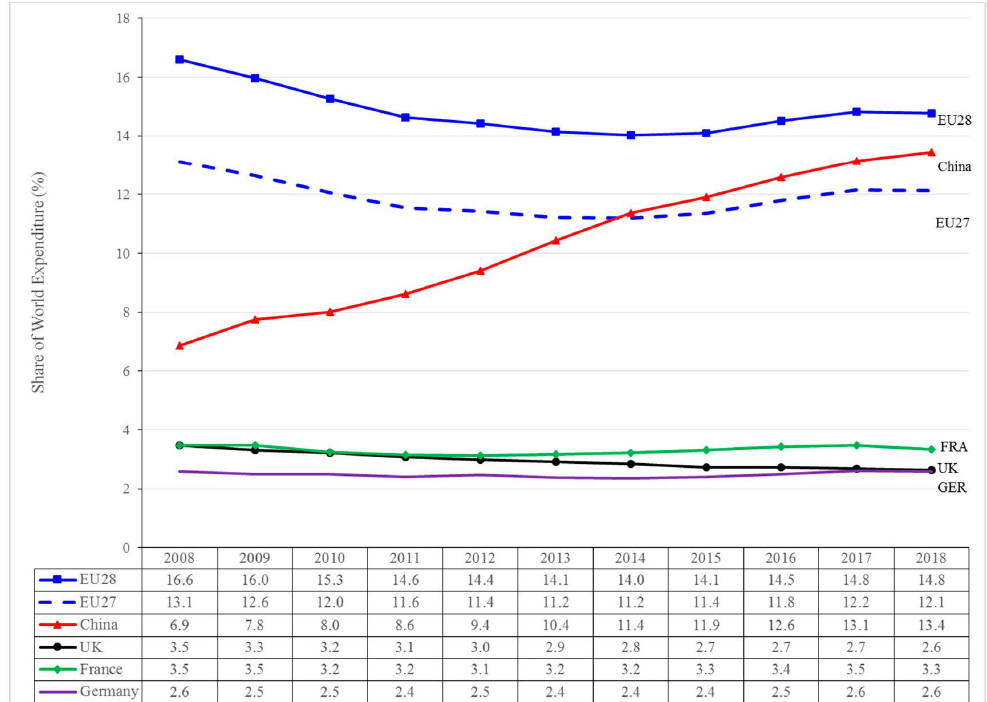
Figure 13 Percentage share of total world defence expenditure, 2008–18. Source: Stockholm International Peace Research Institute, ‘Military Expenditure Database’ (2019) <https://www.sipri.org/databases/milex>